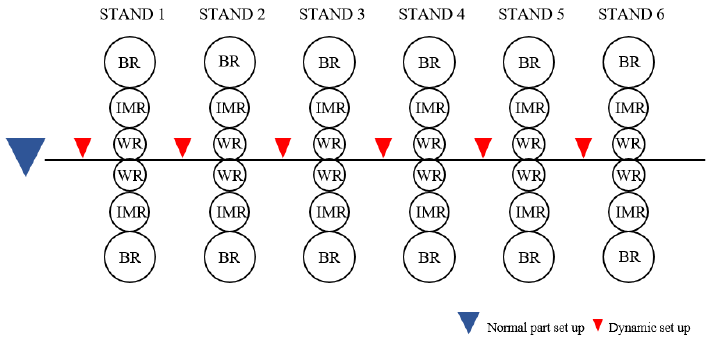
Figure 2. A tandem mill structure and the cold-rolling